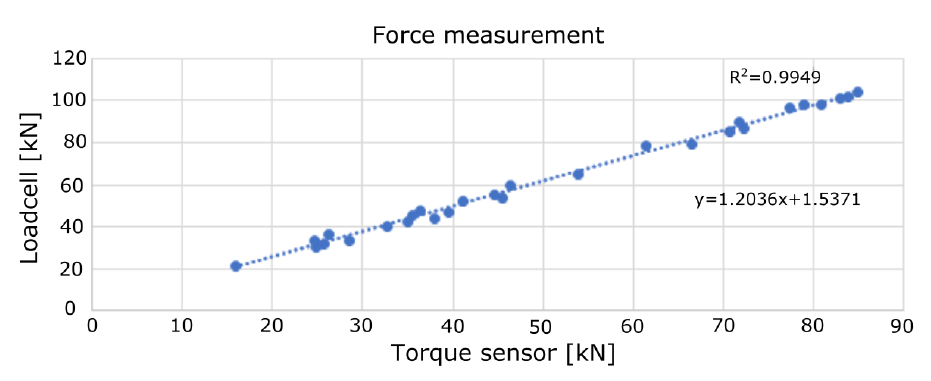
Figure 8. Result from the torque sensor calibration